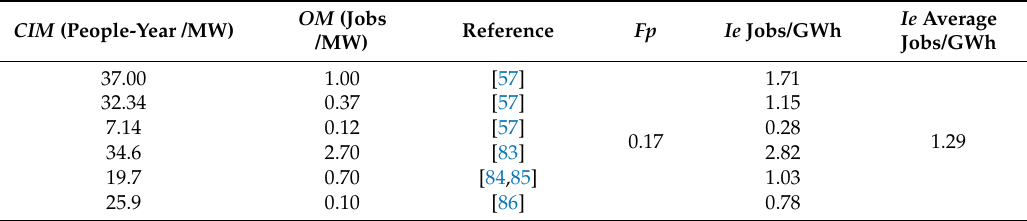
Table 19. The employment indicator (electric power production).